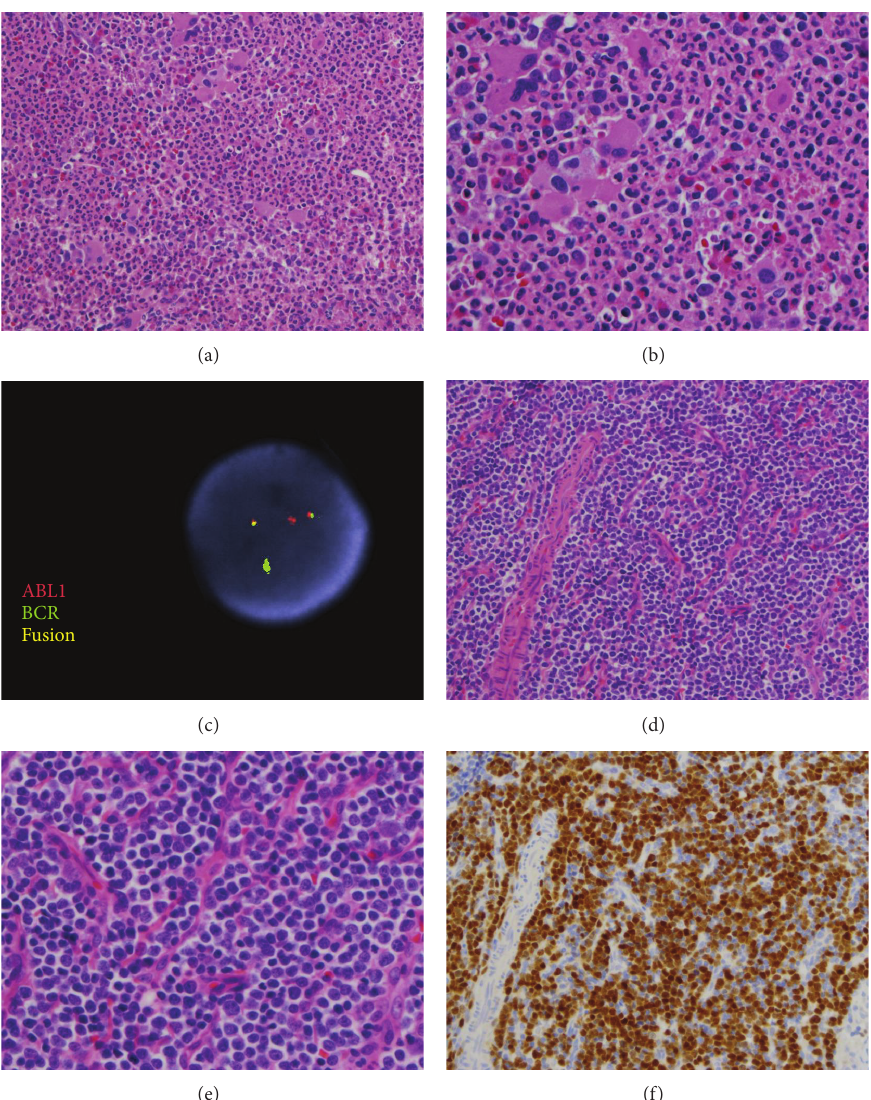
Figure 2: Bone marrow and lymph node biopsies of Case 2. The bone marrow demonstrated typical morphology of chronic myelogenous leukemia, chronic phase ((a) H&E: 200x; (b) H&E: 400x) and FISH showed BCR/ABL1 fusion (c); lymph node demonstrated lymphoblastic lymphoma morphology ((d) H&E: 200x; (e) H&E: 400x) with a T-lymphoblastic immunophenotype by flow cytometry (not shown) and was positive for TdT ((f) immunohistochemistry: